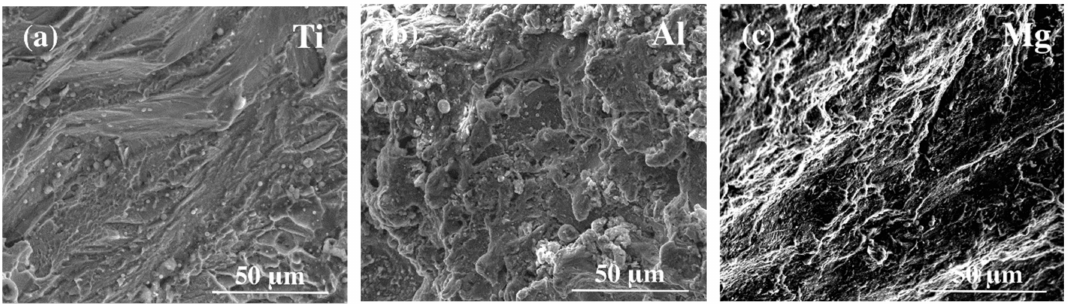
Figure 7. SEM micrographs of the matrix for the sample II. ( a ) Ti-matrix; ( b ) Al-matrix; ( c )